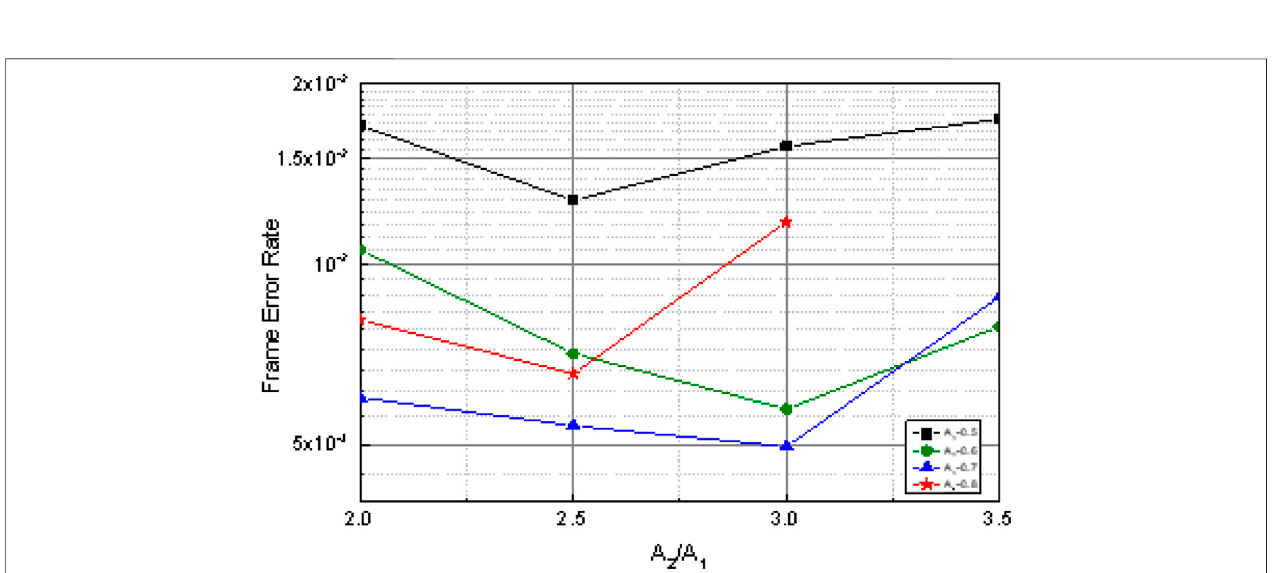
FIGURE 9 | Simulation of BER of 2-bit non-uniform